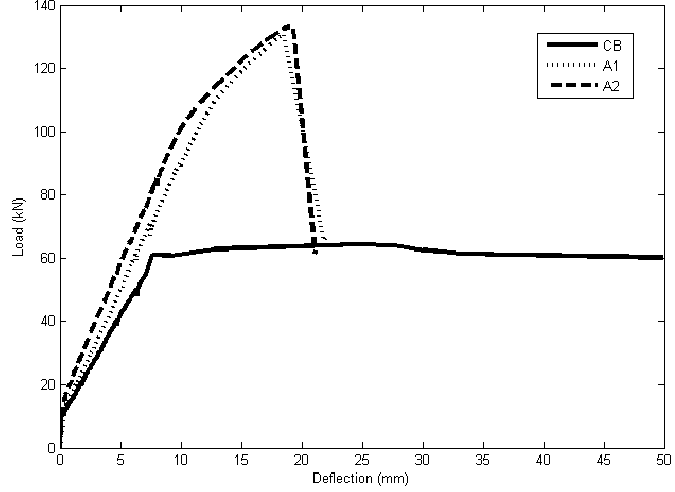
Figure 9. Load-deflection result for beams CB, A1 and A2. Table 4. Summary of Experimental Test Results. P cr = first crack load; P y = yield